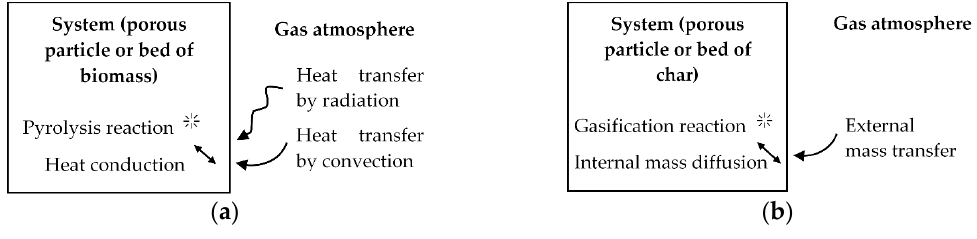
Figure 2. ( a ) Phenomena involved in pyrolysis ; ( b ) Phenomena involved in gasification .